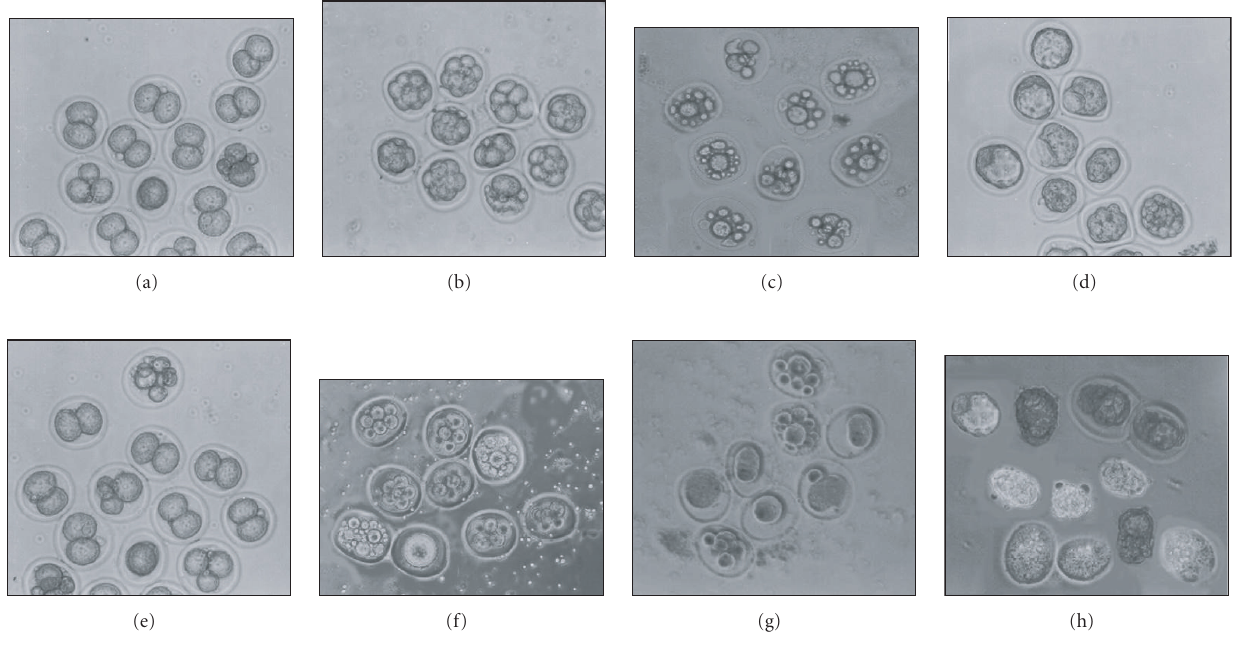
Figure 2: Photograph of embryos recovered from control and LPS-treated superovulated pregnant mice during di ff erent stages of preim- plantation period of pregnancy. Panels (a), (b), (c), and (d) show embryos recovered from control animals on days 1 . 5, 2 . 5, 3 . 5, and 4 . 375 of pregnancy, respectively. Panels (e), (f), (g), and (h) show embryos recovered from the animals treated with the “minimum dose” of LPS on days 1 . 5, 2 . 5, 3 . 5, and 4 . 375 of pregnancy, respectively, X100.